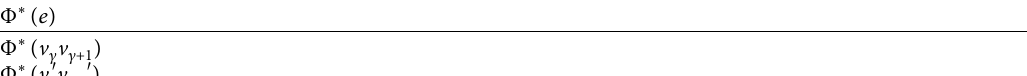
Table 20: Edge labeling of Φ ∗ ( e ) .